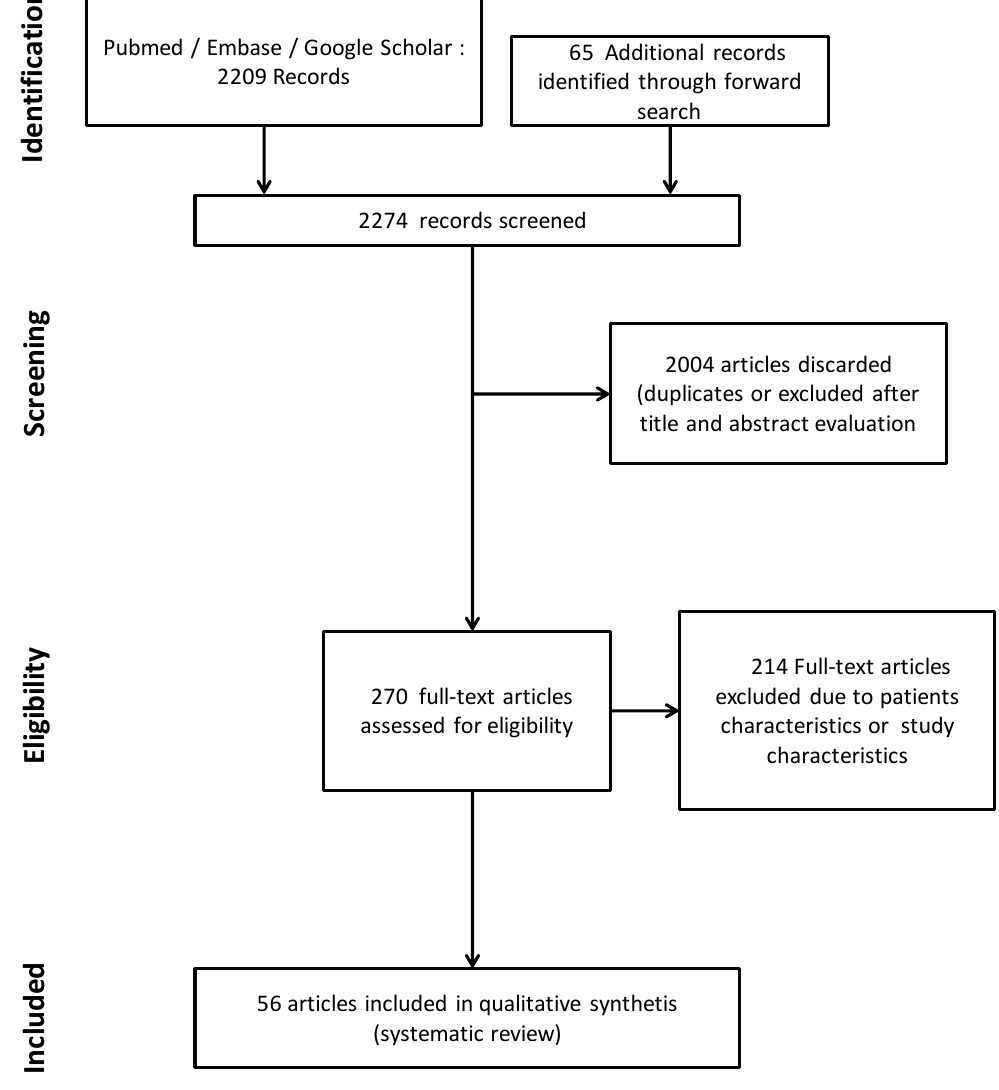
Figure 1. Flow chart of study selection.